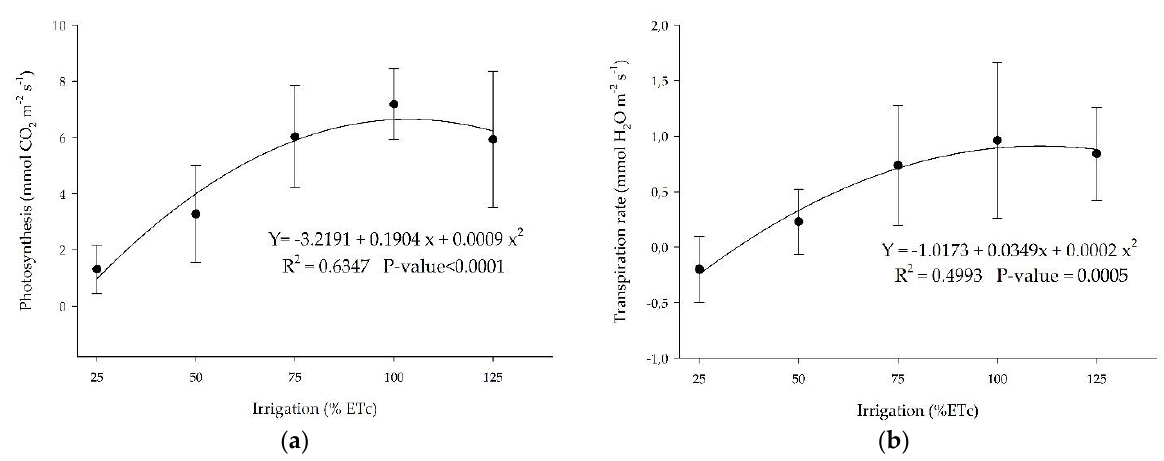
Figure 8. ( a ) Photosynthesis and ( b ) transpiration rate for ‘Ruby Red’ grapefruit submitted to different irrigation levels. Polynomial models adjusted by regression using data from 5 replications. Each data point is the average ± standard deviation of 5 replications. ETc = crop evapotranspiration.